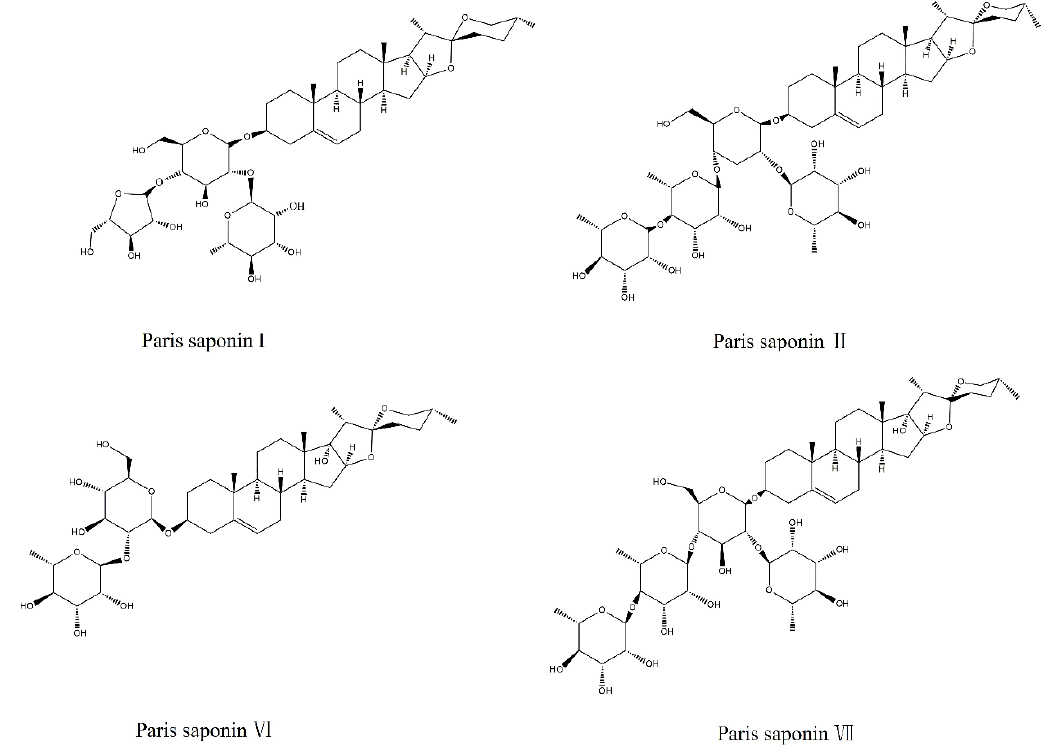
Figure 1. Chemical structures of Paris saponins I, Ⅱ , Ⅵ , and Ⅶ .